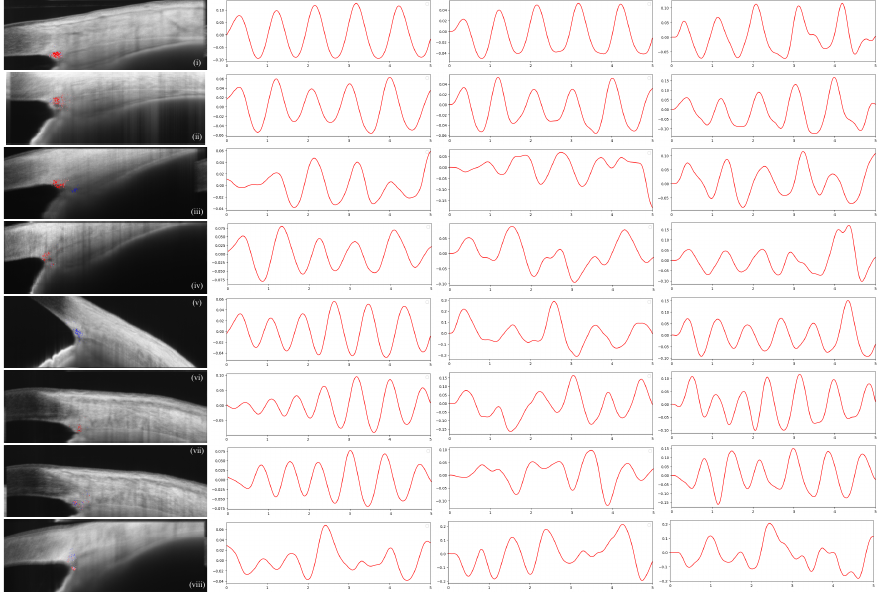
Figure 5. The results of the TM motion signal on the OCT cross-sectional images and the correspond- ing waveform. The first column ( i – viii ) demonstrates the candidate signal region over the OCT structural image. The final signal was reconstructed using the major harmonic frequencies and the SVD method separately, as the second and the third columns shown. The right column is the selected signal from the candidate TM motion